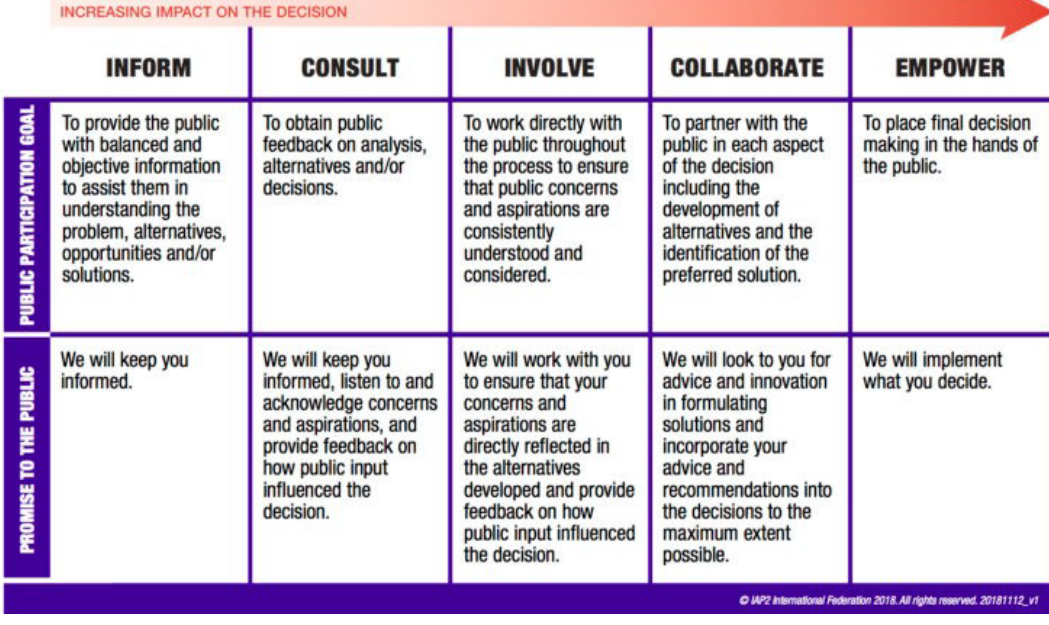
Figure 1 International Association for Public Participation (IAP2) – Spectrum of Public Participation (IAP2,